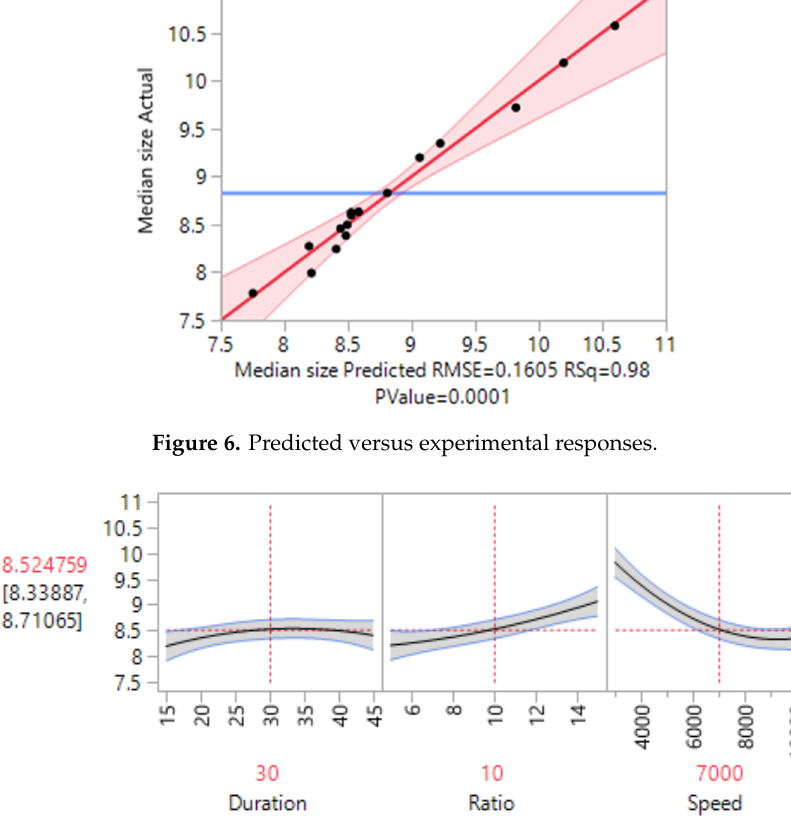
ff ects of individual parameters on the Figure 7. Effects of individual parameters on the response. Figure 7. E